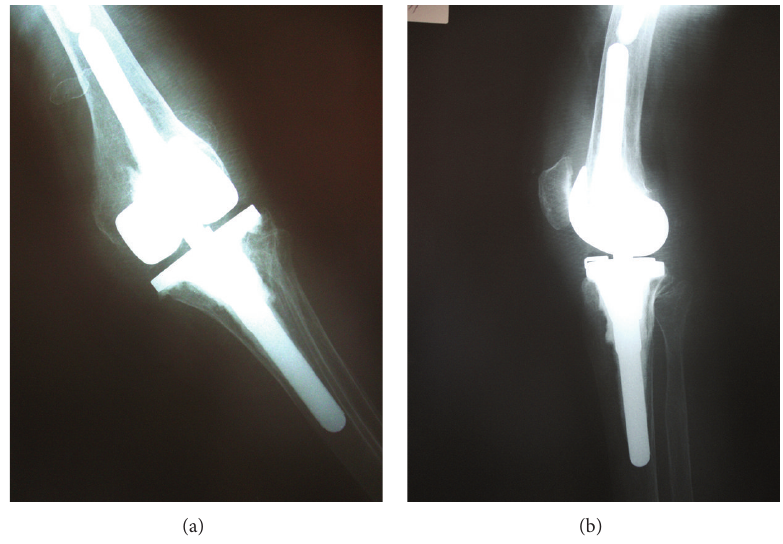
Figure 6: Radiography of the hinged knee prosthesis was